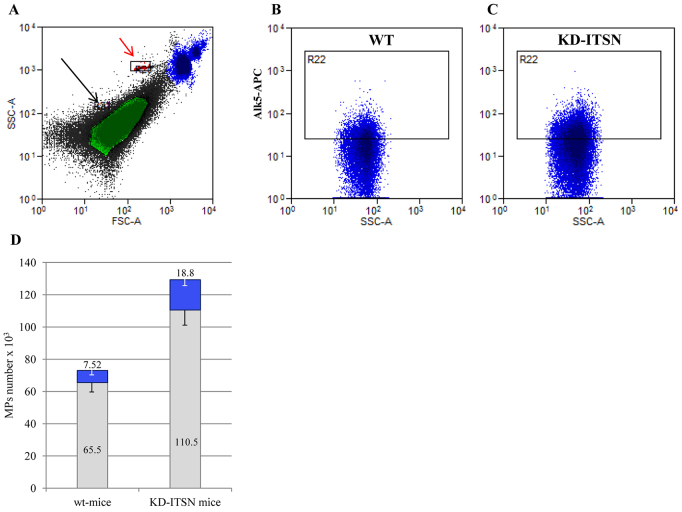

Flow cytometry analyses of microparticles.Flow cytometry analyses of microparticles. (A) The microparticle gate was determined using 1.35-µm Spherotech nano fluorescent size standard beads (a; black arrow). The red arrow in A shows the counting beads (3 µm diameter). (B,C) Representative plots of flow cytometry studies for identification of Alk5-positive microparticles. WT, wild type. (D) An increase in the total number of microparticles (MPs; blue and gray bars together) as well as an increase in Alk5-expressing microparticles (blue bars only) was observed in KD-ITSN mice compared with wild-type mice. Data show the mean±s.e.m.; n = 3 mice for each experimental condition; *P<0.01 versus wild-type mice. Data are representative of three independent experiments.